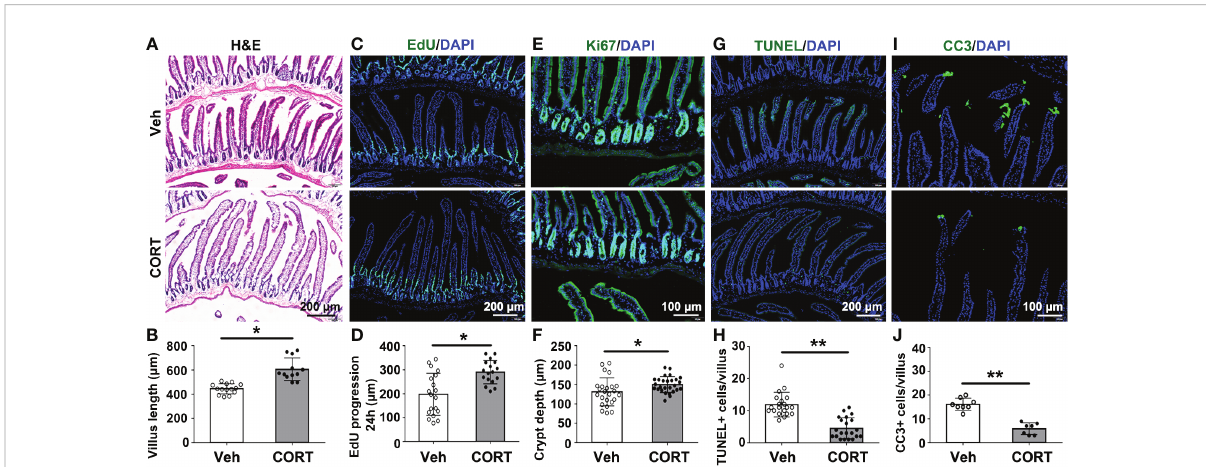
FIGURE 2 CORT increased intestinal villus length by breaking the balance between proliferation and death of intestinal cells. (A) Hematoxylin and eosin (H&E)-staining for duodenum sections. (B) Quantitative analysis of villi length for duodenum from Vehicle- or CORT-treated mice. (C) Immuno fl uorescence staining of EdU for the duodenum sections from Vehicle- or CORT-treated mice. (D) Quanti fi cation of the progression of EdU-labelled cells along the duodenum villi from Vehicle- or CORT-treated mice. (E) Immuno fl uorescence staining of Ki67 for the duodenum sections from Vehicle- or CORT-treated mice. (F) Quanti fi cation of the duodenal crypt depth indicated by Ki67-staining from Vehicle- or CORT-treated mice. (G) Immuno fl uorescence staining of TUNEL for the duodenum sections from Vehicle- or CORT-treated mice. (H) Quanti fi cation of TUNEL-positive cells of duodenal crypt from Vehicle- or CORT-treated mice. (I) Immuno fl uorescence staining of CC3 for the duodenum sections from Vehicle- or CORT-treated mice. (J) Quanti fi cation of CC3-positive cells of duodenal crypt from Vehicle- or CORT- treated mice. Data are expressed as mean ± SEM, *p < 0.05; **p < 0.01. CC3: Cleaved Caspase 3. Veh: vehicle-treated group; CORT: corticosterone-treated